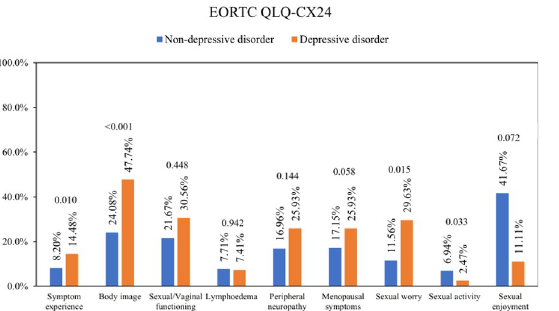
Fig 3. The means of EORTC QLQ-Cx24 scores of the depressed group compared to the non-depressed group, with p-values. A higher percentage on cervical-related symptom scales indicates a poorer quality of life. A higher percentage of sexual activity and sexual enjoyment indicates a better quality of life. Abbreviations: EORTC QLQ-Cx24, EORTC Cervical Cancer Module. P-values < 0.050 were considered statistically significant.